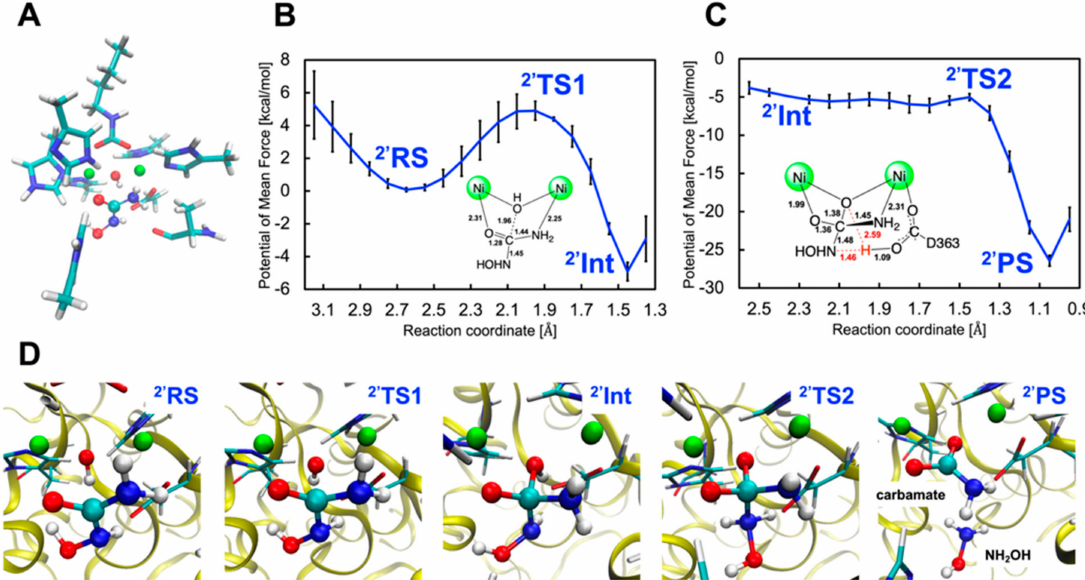
Figure 3. ( A ) QM region of HU( 2 (cid:48) )-bound complex ( 2 RS ) obtained with the QM/MM MD equilibra- tion; ( B ) one-dimensional potentials of mean force (1D-PMFs) for the nucleophilic addition step, with an illustration of 2 (cid:48) TS1 (key distances are provided in Å); ( C ) 1D-PMFs for the release of NH 2 OH and HU-inhibited complex formation, with an illustration of 2 (cid:48) TS2 (key distances are provided in Å); and ( D ) representative snapshots of the active site in 2 (cid:48) RS , 2 (cid:48) TS1 , 2 (cid:48) Int , 2 (cid:48) TS2, and 2 PS